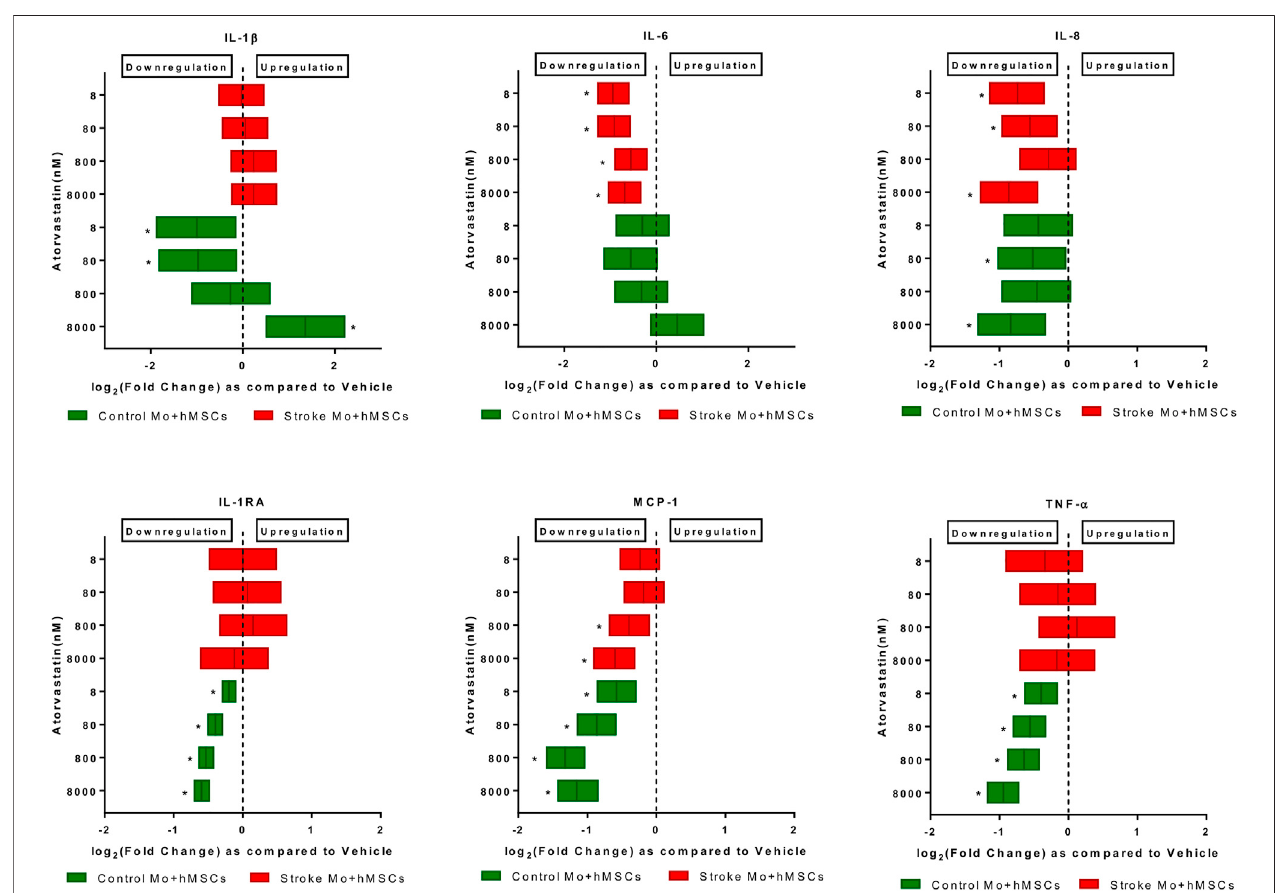
FIGURE3| Atorvastatin reducesthecytokinesecretionsofIL-6,IL-8,andMCP-1fromco-culturesofstrokepatientmonocytes withMSCsafter24 hofexposure. Atorvastatin also reduces IL-1RA, TNF- α , IL-8, MCP-1 and IL-1 β secretions from co-cultures of healthy control monocytes with M-SCs after 24 h of exposure. Signi fi cance is shown by * p <